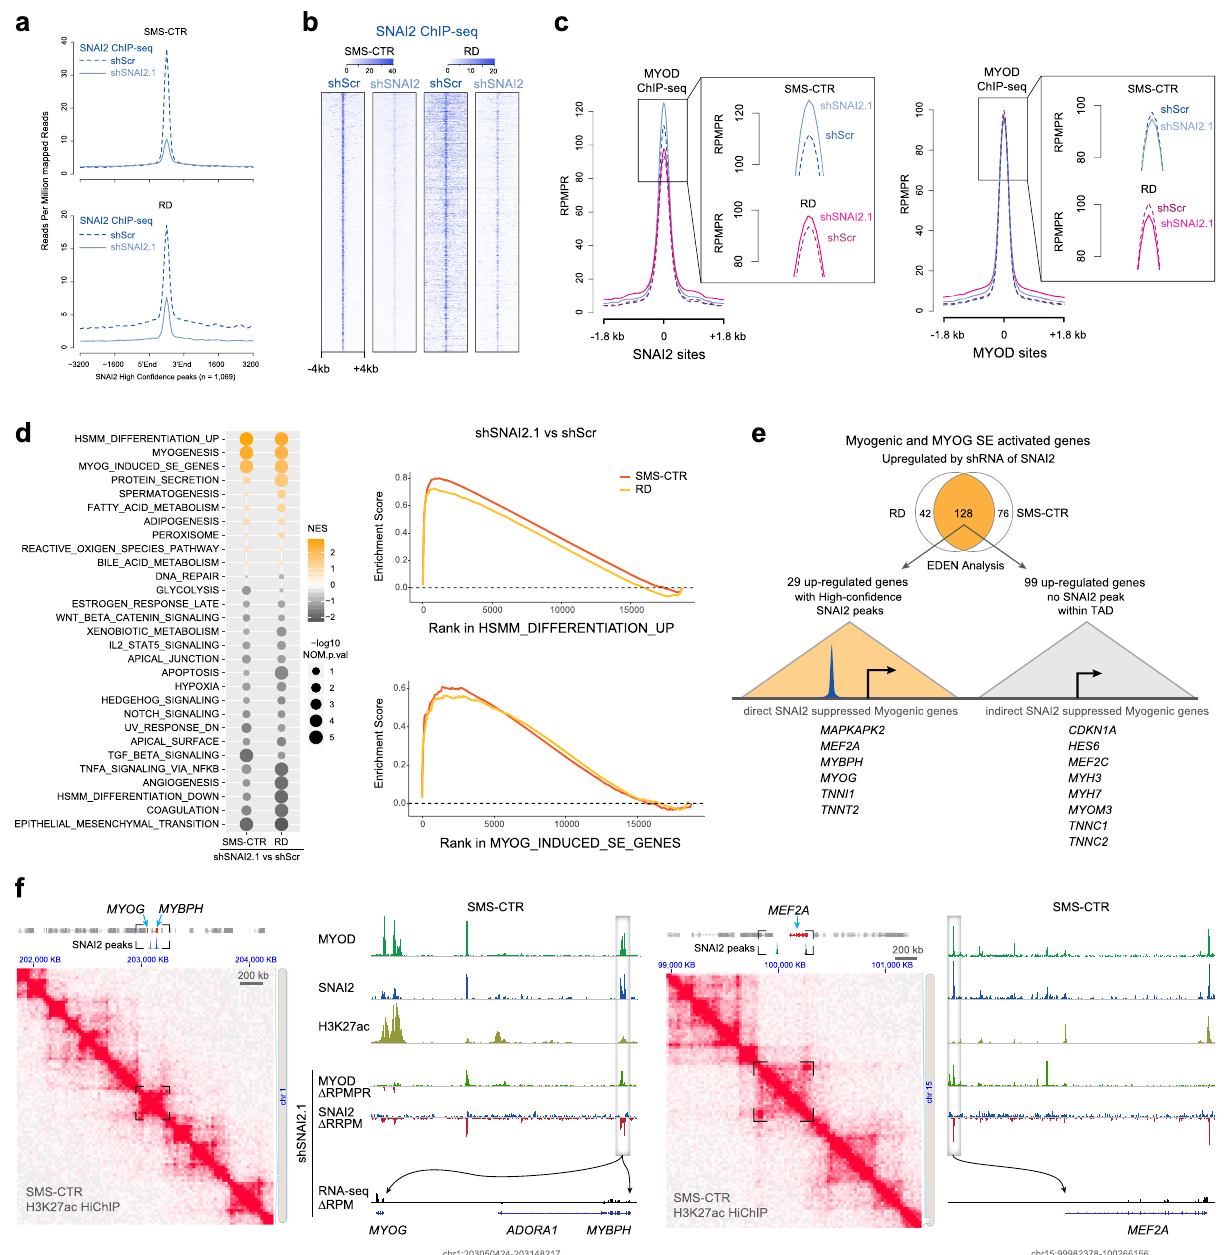
Fig. 5 Ablation of SNAI2 enables MYOD to activate myogenic target genes. a Composite plots showing SNAI2 signal intensities (reads per million mapped reads) at SNAI2 high con fi dence peaks ( n = 1069) in SMS-CTR (top) and RD (bottom). b Heatmaps of SNAI2 peak intensity at SNAI2 high con fi dence peaks. Each row represents a genomic location and is centered around SNAI2 peaks, extended 4 kb in each direction, and sorted by SNAI2 signal strength. c Composite plots showing MYOD signal intensities at SNAI2 high con fi dence peaks (left) and at MYOD peaks (right) in SMS-CTR and RD. RPMPR, Reads Per Million Mapped Peak Reads. d Bubble plot depicting Gene Set Enrichment Analysis (GSEA) in SMS-CTR and RD cells (left). The size of the bubble is proportional to the − log10 nominal (NOM) p , and the color of the bubble corresponds to the normalized enrichment score (NES) value. GSEA enrichment plots showing positive enrichment for a set of genes up-regulated during differentiation of human skeletal muscle myoblasts into myotubes (right, top), and a set of myogenically induced super-enhancer genes (right, bottom). p values are determined by the GSEA algorithm relative to the null distribution calculated with 1000 permutations. For each of the enrichment plots shown here, the false discovery rate (FDR) q value and the nominal p value is <0.0005. e Diagram illustrating SNAI2 direct or indirect myogenic target genes through EDEN analysis. SE, Super Enhancer; TAD, Topologically Associated Domain. f Sites of direct SNAI2 mediated gene suppression at MYOG , MYBPH (left), and MEF2A (right), with both H3K27ac HiChIP for 3D chromatin folding and ChIP-seq. Representative ChIP-seq tracks are shown for MYOD, SNAI2, H3K27ac, and delta ( Δ ) value (shSNAI2.1 minus shScr) in MYOD and SNAI2 and gene expression (RNA-seq) at MYOG , MYBPH , and MEF2A loci in SMS-CTR. Arrows depict SNAI2/ MYOD regulation on direct target myogenic genes. RPMPR, Reads Per Million Mapped Peak Reads; RRPM, Reference-adjusted Reads Per Million Mapped Reads; RPM, Reads Per Million Mapped